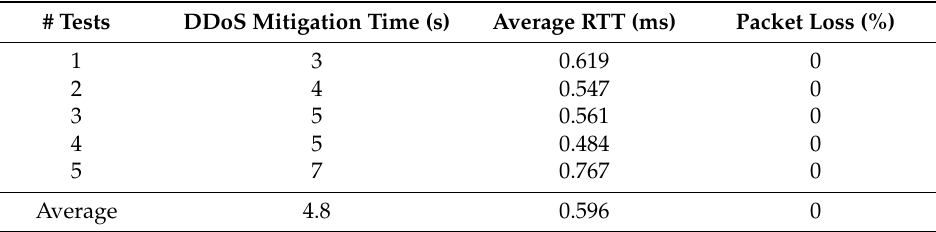
Table 4. Scenario I—Performance Results.